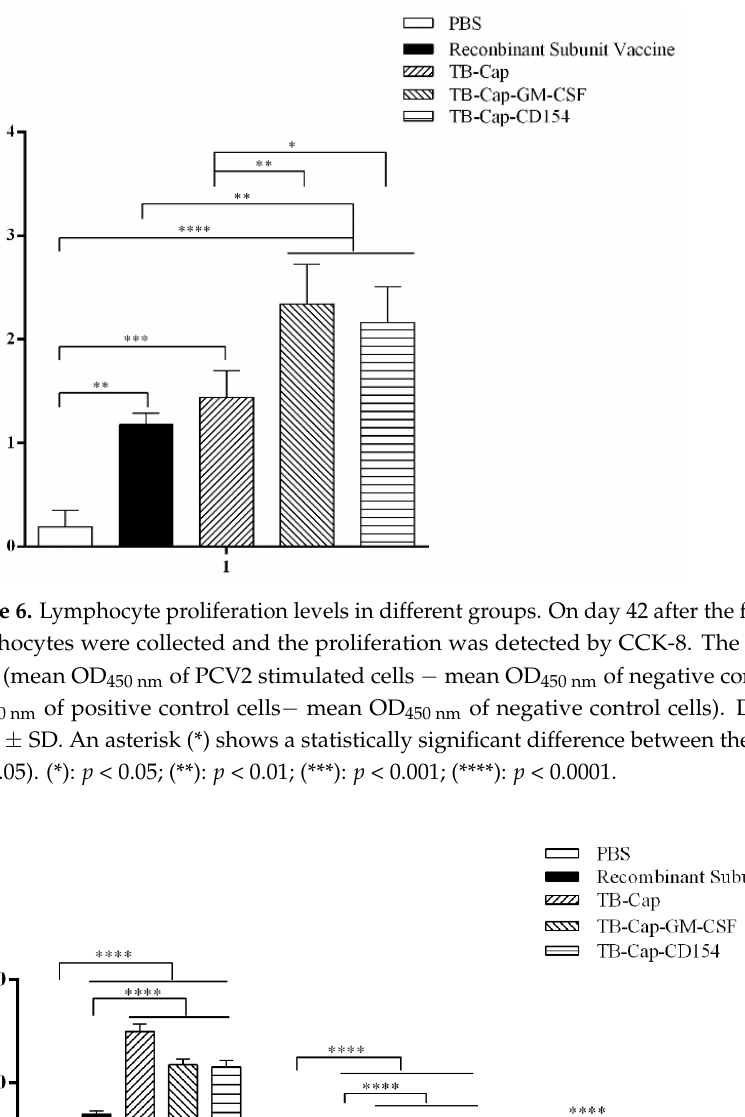
Figure 7. The changes of lymphocyte subsets after immunization were analyzed by flow cytometry. On day 42 after the first immunization, lymphocytes were collected and CD4+ T cells and CD8+ T cells were analyzed by flow cytometry. Data represent the mean ± SD. An asterisk (*) shows a statistically significant difference between the indicated groups ( p < 0.05). (**): p < 0.01; (****): p < 0.0001. Table 3. Analysis of CD4+ and CD8+ of immunized mice by flow